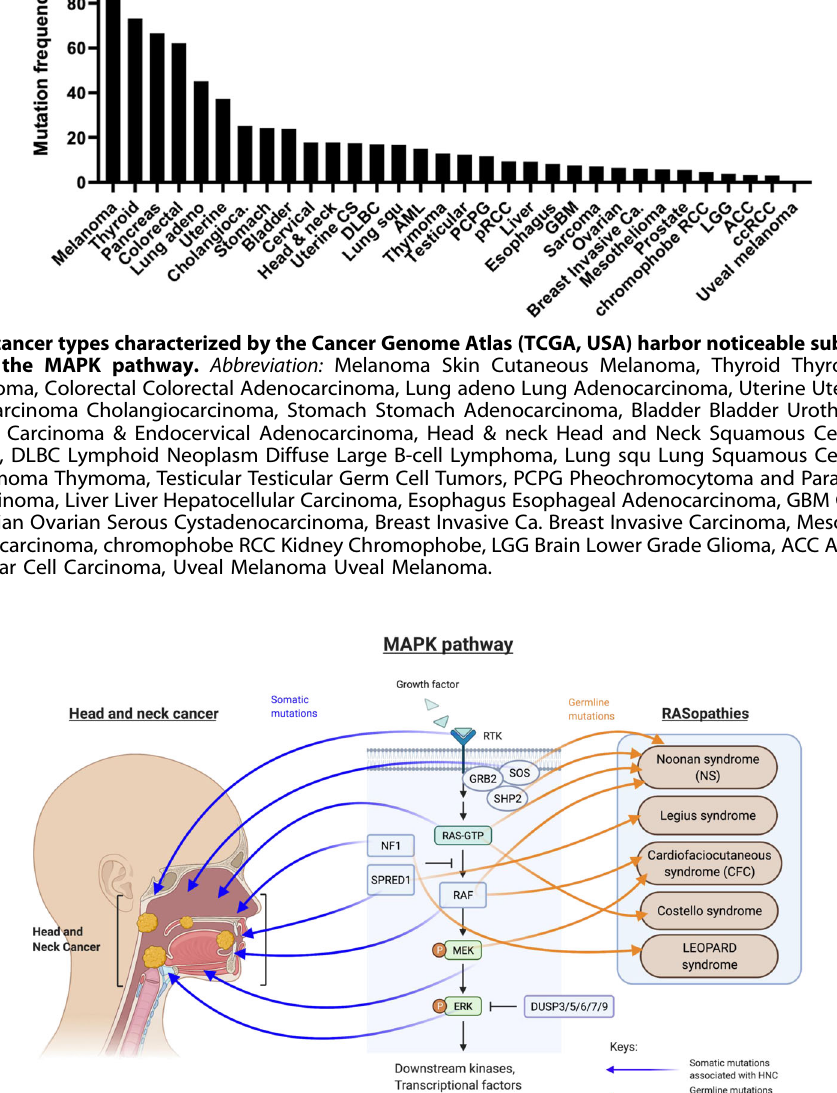
regulating the development and growth of the head and neck region in human. Gain-of-function mutations of BRAF p.Q257R, MEK1 p.Y130C and MEK2 p.F57C are clinically associated with cardiofaciocutaneous (CFC) syndrome, KRAS p.T58I and RAF1 p. S257P mutations with Noonan syndrome, HRAS p.G12S mutation with Costello syndrome, NF1 mutation with LEOPARD syndrome,